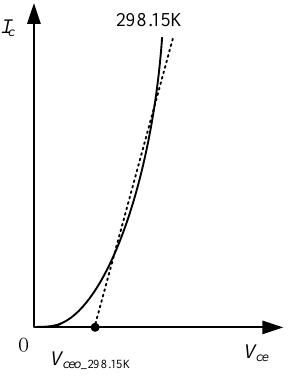
Figure 2. I - V characteristic curve of IGBT.